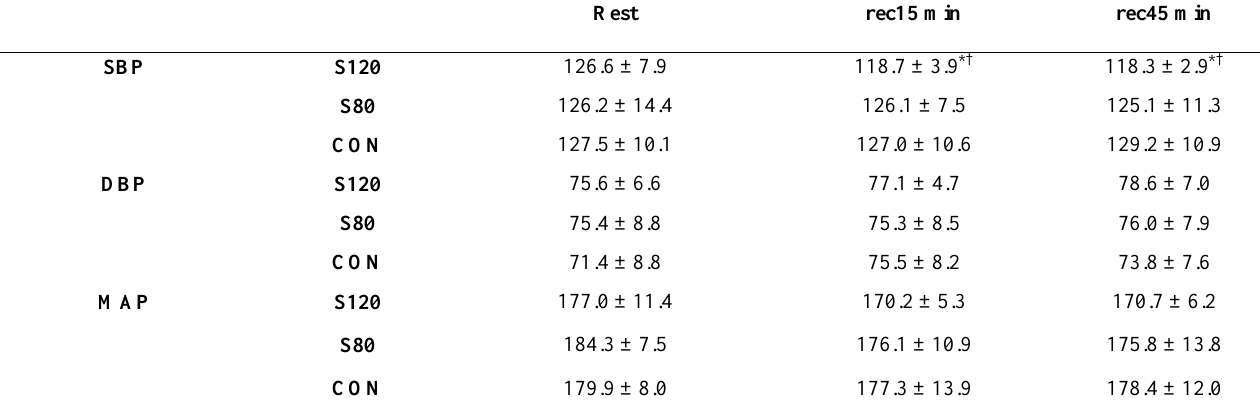
Table 3. Between and within comparisons of blood pressure (mmHg) in individuals with type-2 diabetes (n=11). Data expressed in mean ± standard deviation.